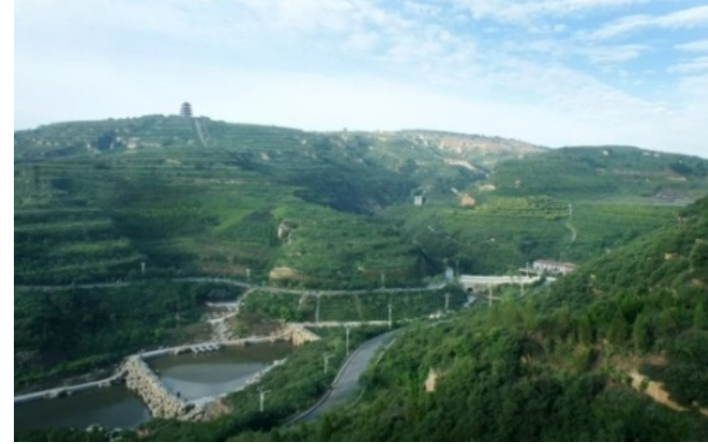
Figure 3. Ecological restoration of Xishan in Wanbailin District.